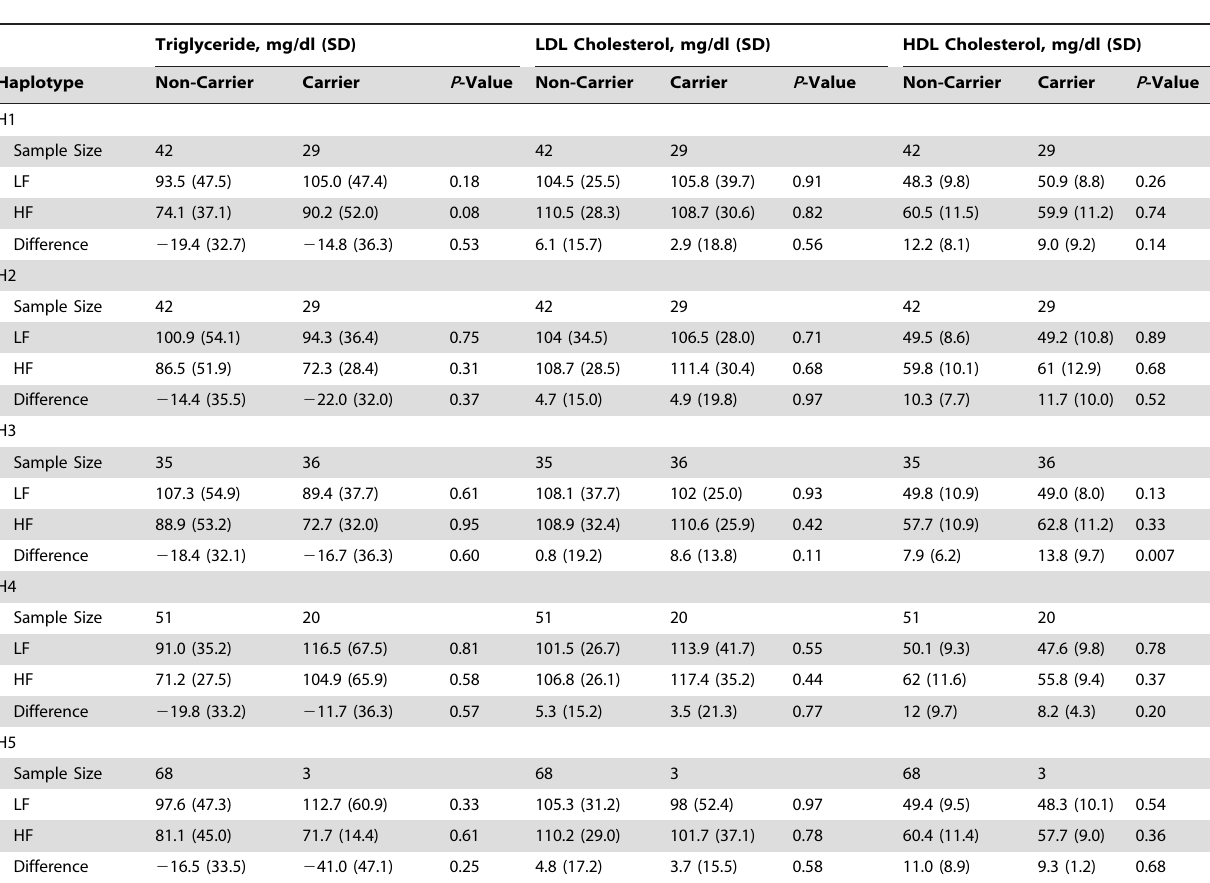
Table 3. Effect of haplotype on triglycerides, LDL-cholesterol and HDL-cholesterol in 71 normal to overweight females (cohort # 2) on eucaloric